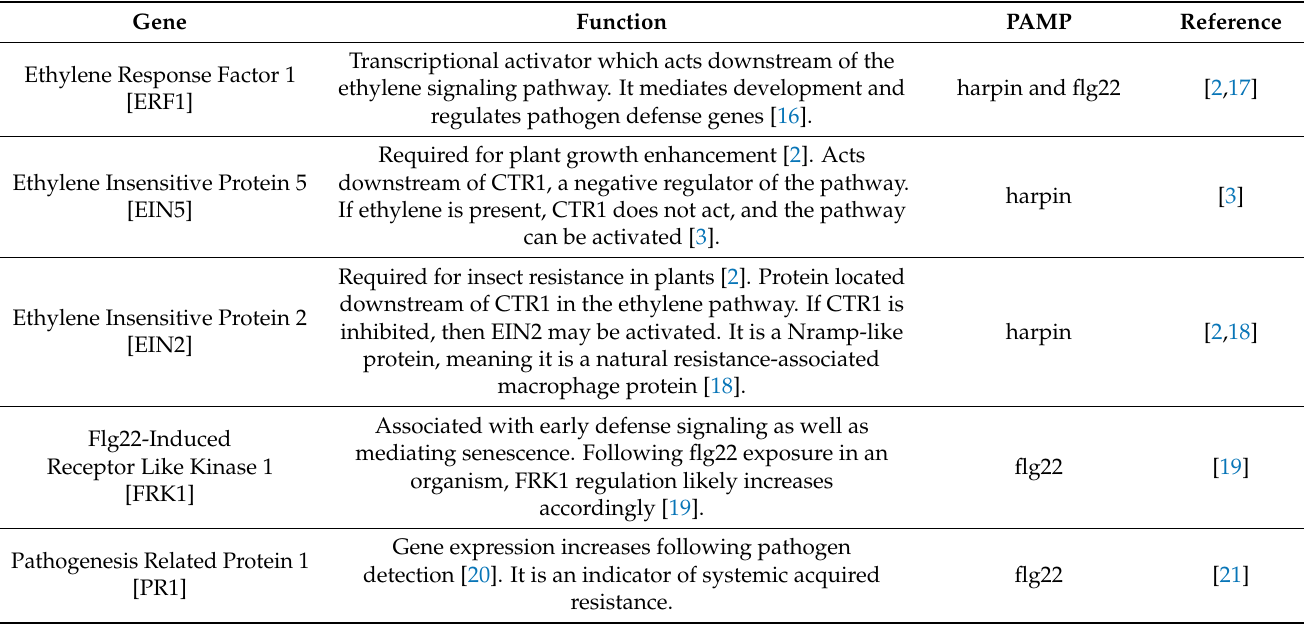
Table 1. Summary of homologs of cannabis genes used in